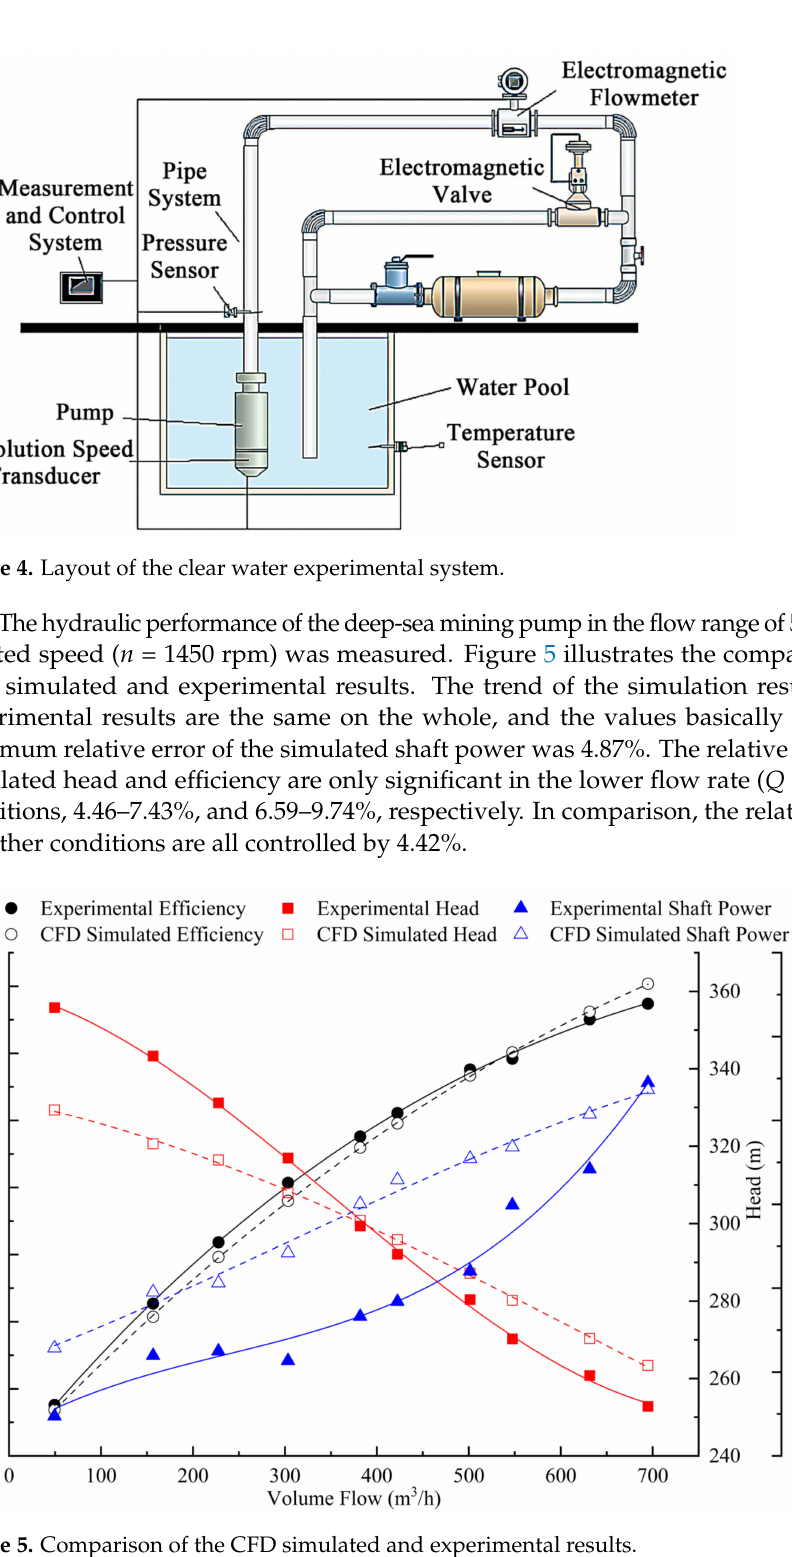
Figure 5. Comparison of the CFD simulated and experimental